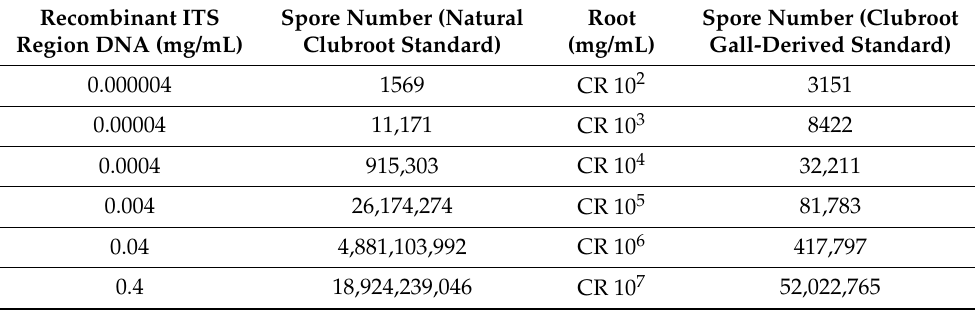
Figure 3. PCR amplification of recombinant clubroot DNA versus clubroot DNA from natural sources (galls). This graph demonstrates the sensitivity of recombinant clubroot DNA at increasing concentrations of DNA. Spore number represents the final amount of DNA amplified after the PCR reaction. The graph illustrates that the spore number increases as the concentration of recombinant DNA increases, indicating that the recombinant clubroot DNA can be amplified at a range of concentrations and is sensitive to different concentrations. For reference, a commercial clubroot standard is also included. Table 1. Comparison of the detection of recombinant ITS region DNA with DNA extracted from galls infected with clubroot. As the concentration of recombinant DNA increases, the spore number also increases. This relationship is also reflected by the infected root samples. Spore number increase correlates to higher spore concentrations. Final results are represented by mean spore numbers derived using a qPCR